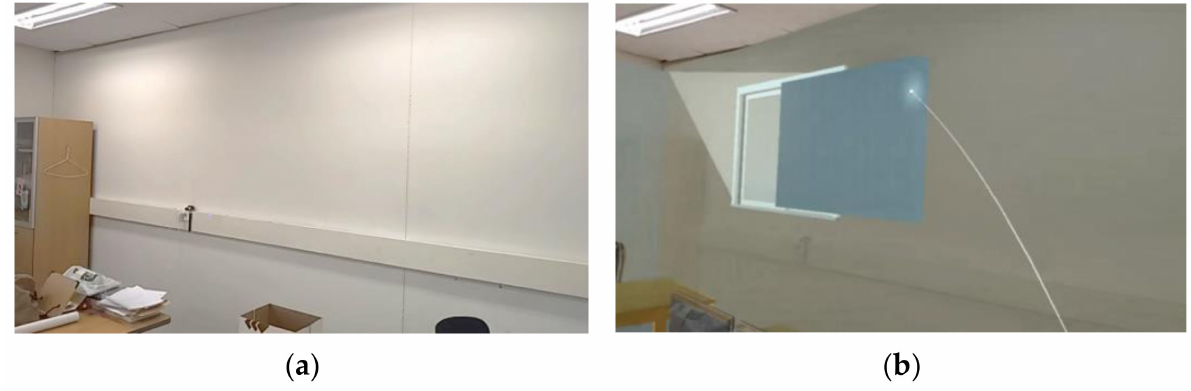
Figure 9. Real-world view with a virtual window on laboratory wall: ( a ) Real-world view of the laboratory wall; ( b ) Real-world view with a virtual window.